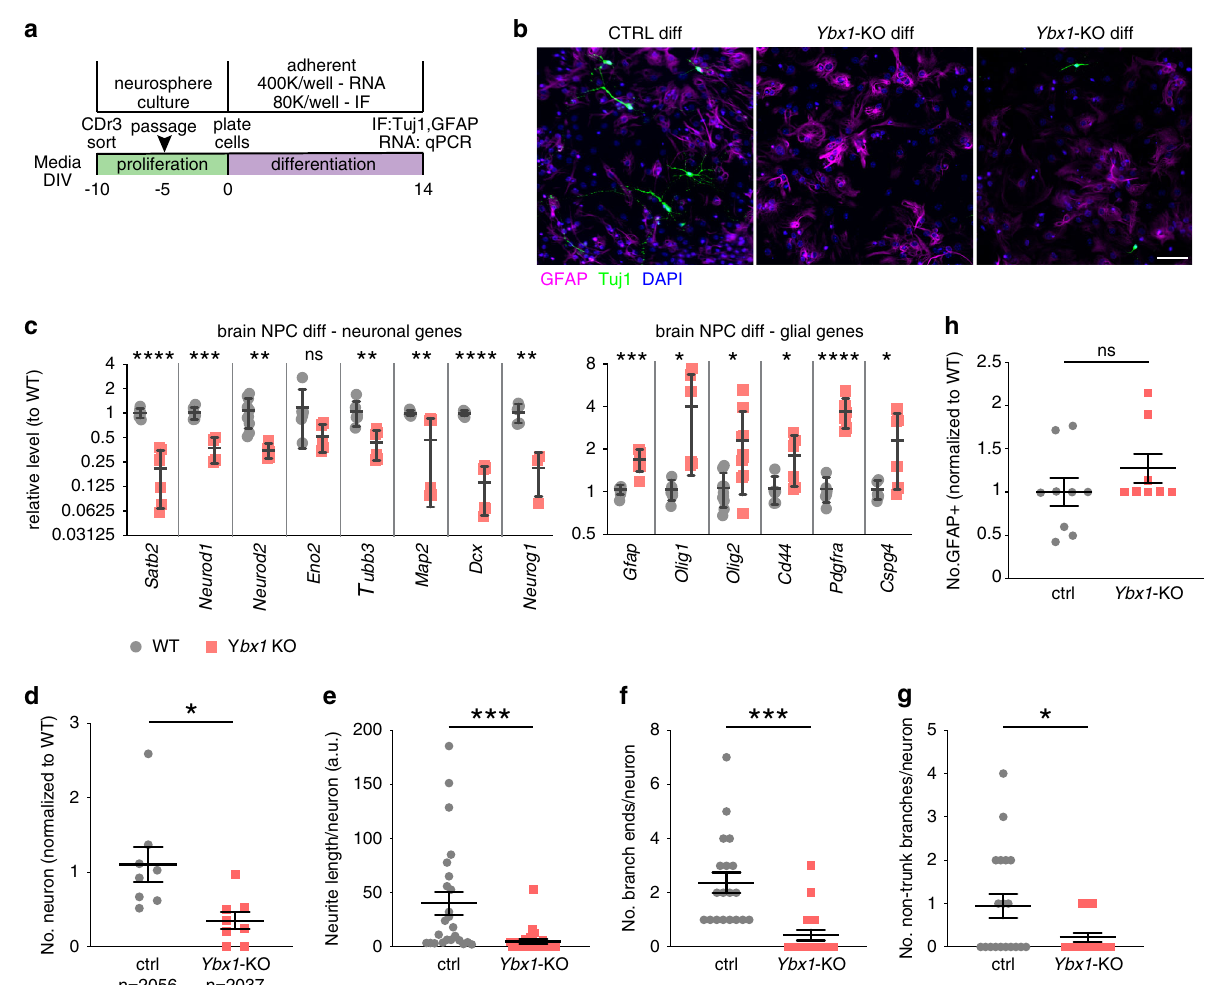
Fig. 3 Ybx1 is required for the differentiation of NPCs to neurons. a Diagram illustrating the work fl ow of in vitro differentiation of NPCs. b IF of Tuj1 and Gfap in Ybx1 -KO and sibling control differentiating cells. c RT-qPCR with TaqMan assays of neuronal and glial genes in control and Ybx1 -KO differentiating cells at day 14. n = 6/genotype. n = 10 for Neurod2 in WT, and n = 10 for Olig2 (see source data). Quanti fi cation of d relative number of Tuj1-positive neurons, e neurite length, f number of branch points in axons, g number of non-trunk branches (not connected to axons or dendrites; n = 8 images and cell numbers indicated), and h number of Gfap-positive (glial marker; n = 9 control images and 8 Ybx1 -KO images) cells in Ybx1 -KO and sibling control differentiating cells. Data are presented as mean ± SEM for c – h . P values by two-tailed unpaired t test are indicated. n.s. indicates not signi fi cant. *, **, ***, and **** indicate P < 0.05, 0.01, 0.001, and 0.0001, respectively. Source data are provided in Source Data fi le. P values: 3 c (Satb2)-<0.0001, (NeuroD1)- 0.0003, (NeuroD2)-0.003, (Tubb3)-0.004, (Map2)-0.009, (Dcx)-<0.0001, (NeuroG1)-0.003, (Gfap)-0.0005, (Olig1)-0.02, (Olig2)-0.01, (Cd44)-0.04, (Pdgfra)<0.0001, (Cspg4)-0.03; 3 d -0.01; 3 e -0.002; 3 f -0.0001; 3 g